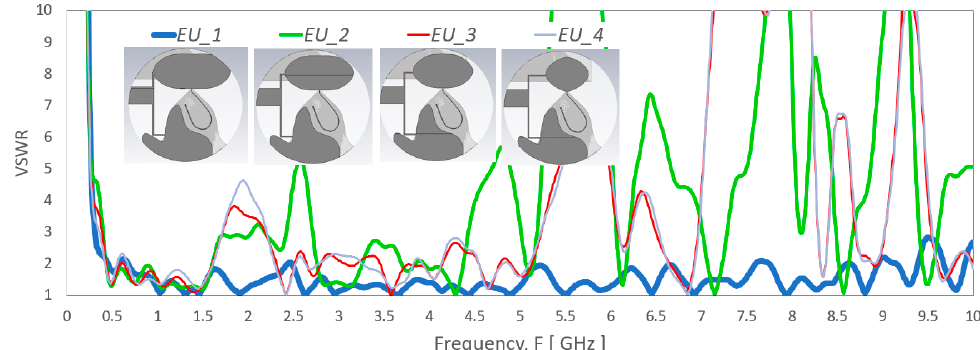
Figure 15. VSWR of the antenna with a different set of spline points ( EU_1 , EU_2, EU_3 and EU_4 ) that construct the monopole elliptical-liked radiator patch. PatchPoints1 to PatchPoints7 defines the set of spline points in ( EU_1 , EU_2, EU_3 and EU_4 ) that related to PatchL.